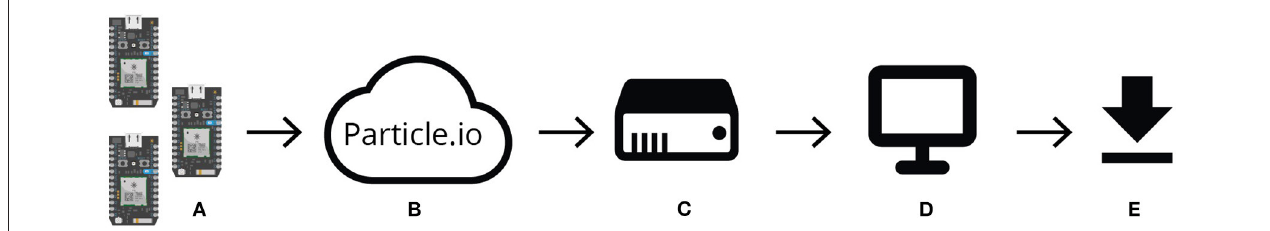
FIGURE 2 | Data collection system overview. Data from an arbitrary number of microcontrollers (A) is published to Particle.io’s Cloud API (B) . Our server (C) scrapes the data, and stores it in an instance of InfluxDB, where client (D) can view the data in Grafana and download for analysis (E) .